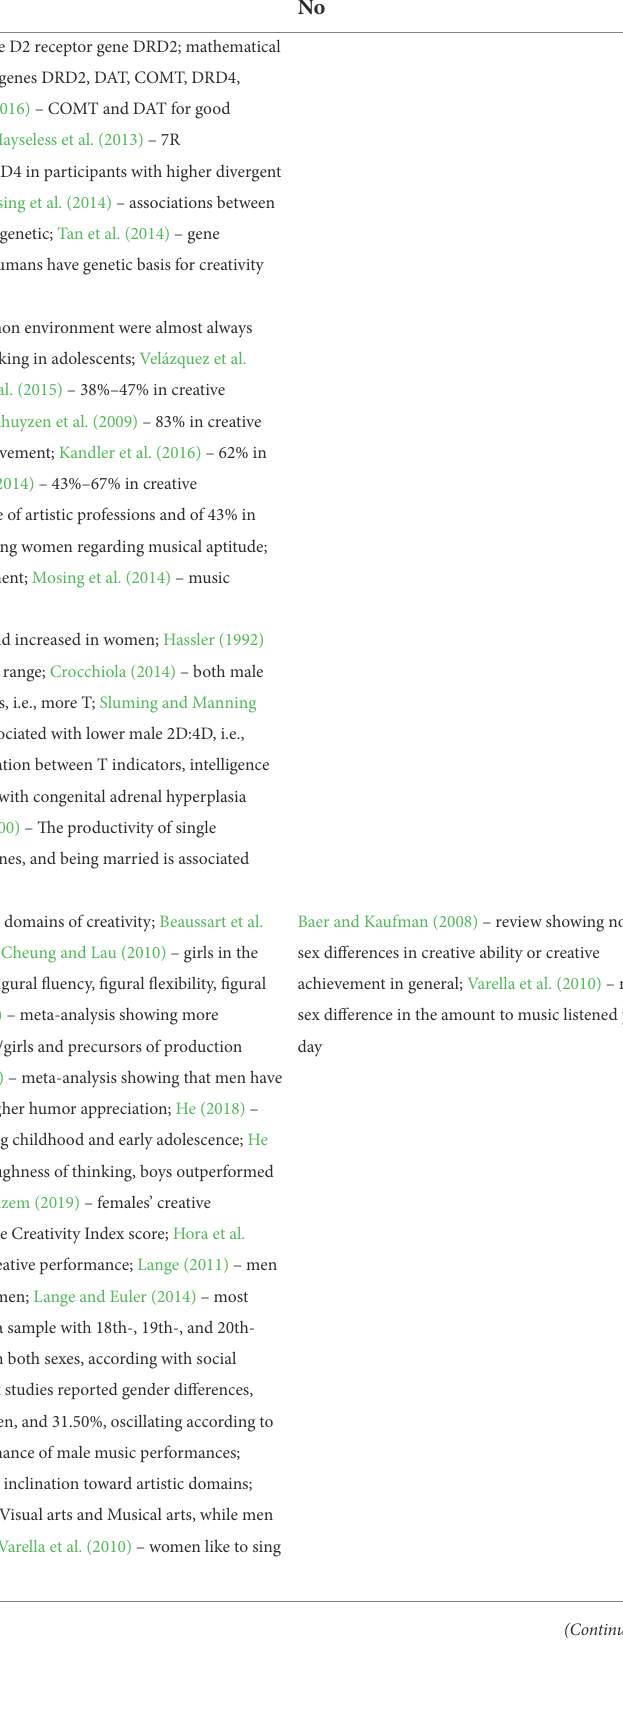
TABLE 1 Predictions based on sexual selection and supporting